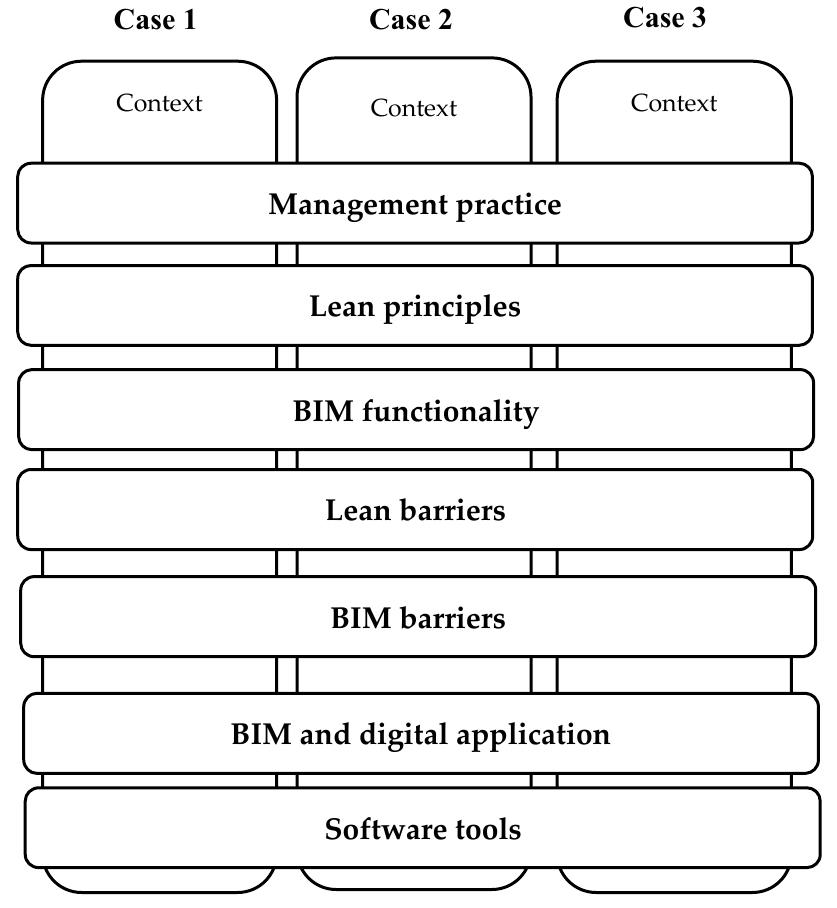
Figure 1. The case study framework used for comparative case study analysis .